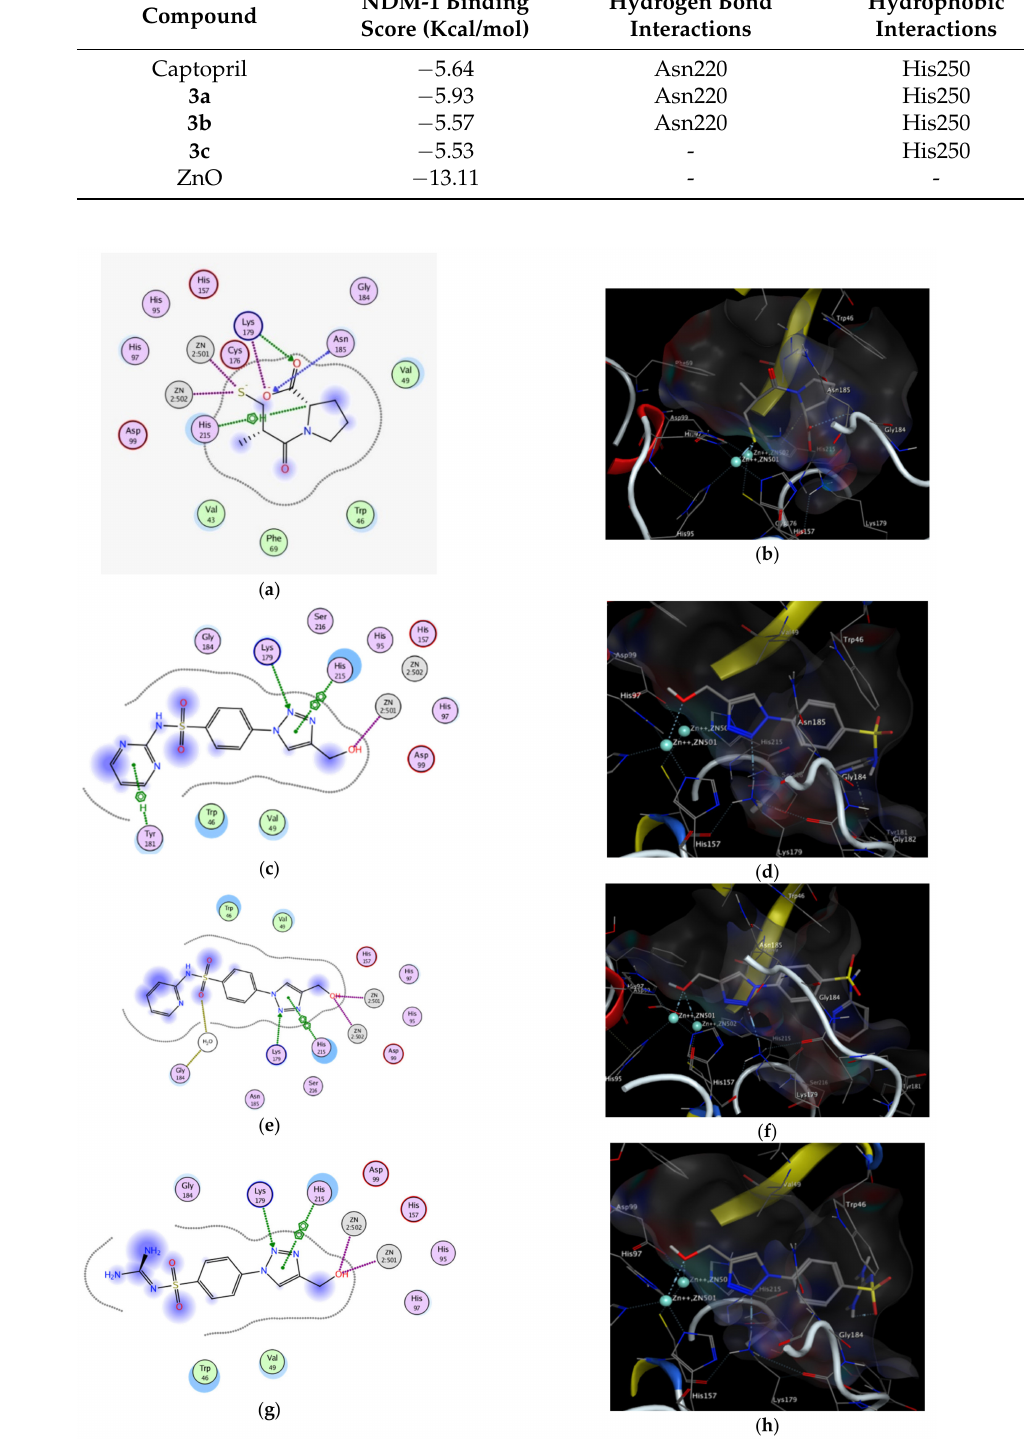
Figure 4. Docking study of the synthesized compounds against IMP-1. ( a ) Two-dimensional binding mode of L-captopril, ( b ) 3D binding mode of L-captopril, ( c ) 2D binding mode of compound 3a , ( d ) 3D binding mode of compound 3a , ( e ) 2D binding mode of compound 3b , ( f ) 3D binding mode of compound 3b , ( g ) 2D binding mode of compound 3c , ( h ) 3D binding mode of compound 3c inside IMP-1 active